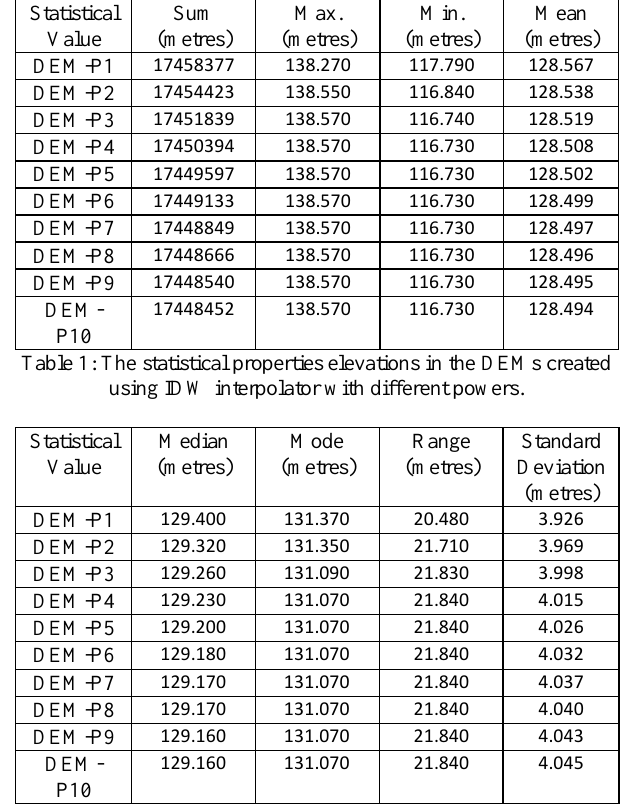
Table 2: The statistical properties elevations in the DEMs created using IDW interpolator with different powers.